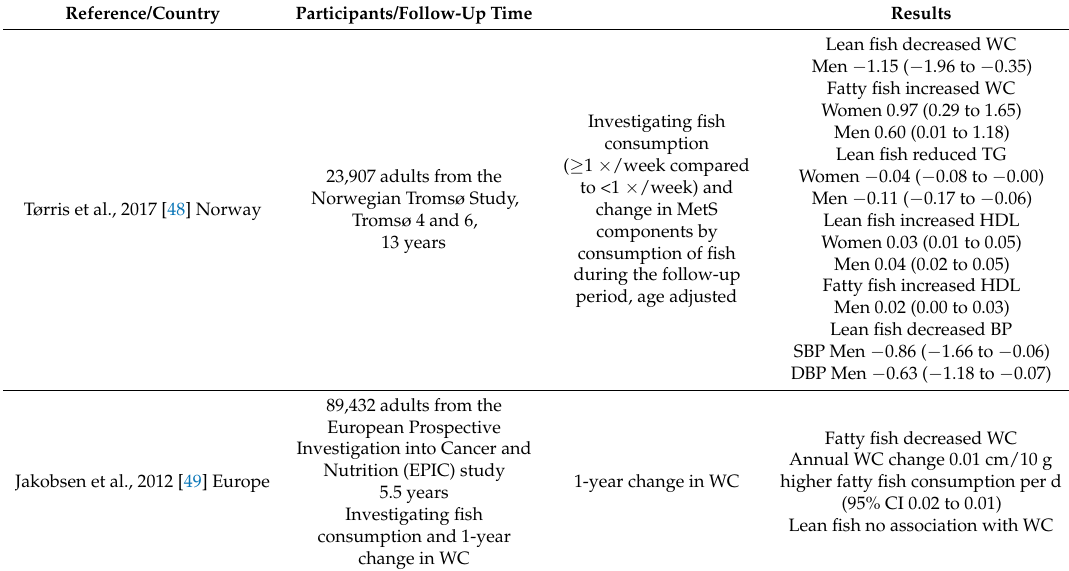
Table 4. Follow-up studies on fish consumption and the metabolic syndrome risk factors, assessing lean and fatty fish separately.